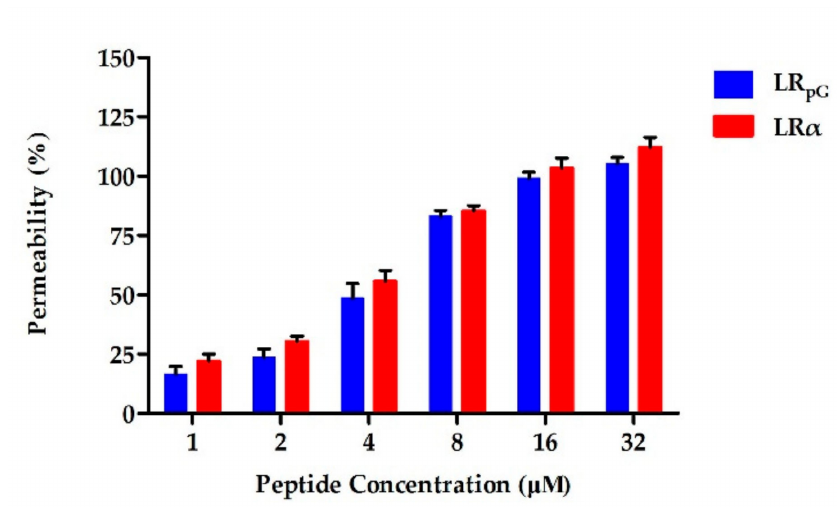
Figure 3. Outer membrane permeability of LR pG and LR α at the concentrations from 1 to 32 µ M. The diagram is based on at least three independent experiments.